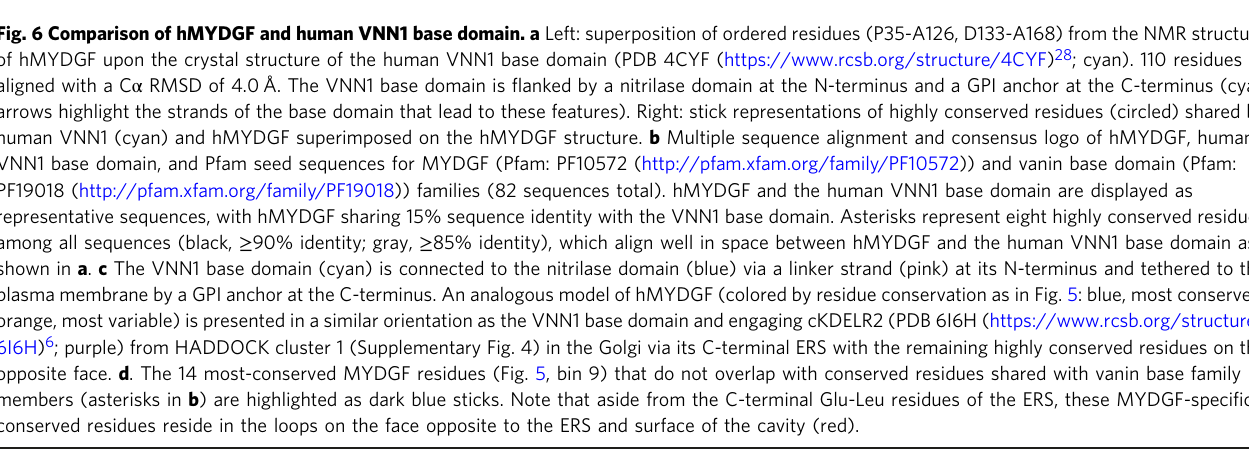
human protein (V32-L173; UniProt Q969H8 (https://www.uniprot.org/uniprot/ Q969H8)) was subsequently ampli fi ed by polymerase chain reaction and cloned